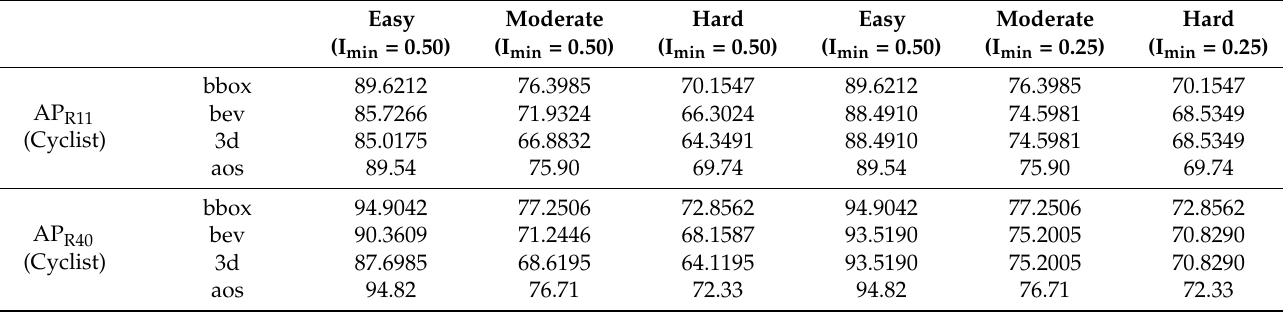
Table 4. The Performance of PointRCNN in the cyclist class of KITTI with different